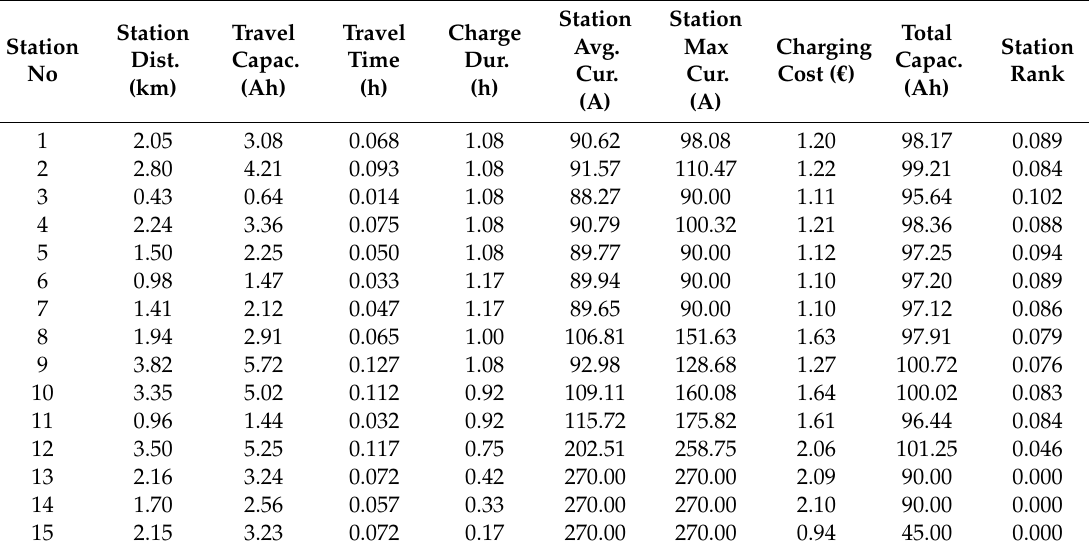
Table 10. The detailed CS quotation for Scenario